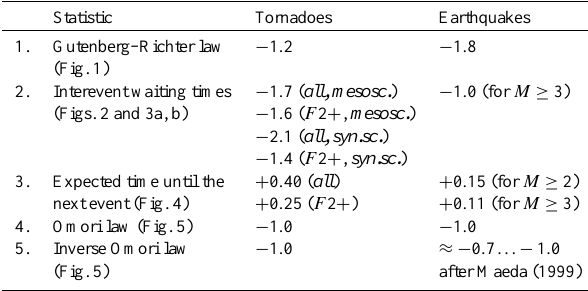
Table 3. Exponents of power law pdfs (estimates) of tornadoes and earthquakes. Abbreviations: F 2 + : tornadoes with Fujita intensities larger than or equal to F 2, all : tornadoes of all intensities, mesosc. : mesoscale (here: times between 60 and 600min), syn.sc. : synoptic scale (here: times larger than one day), M : magnitude. Statistic Tornadoes Earthquakes